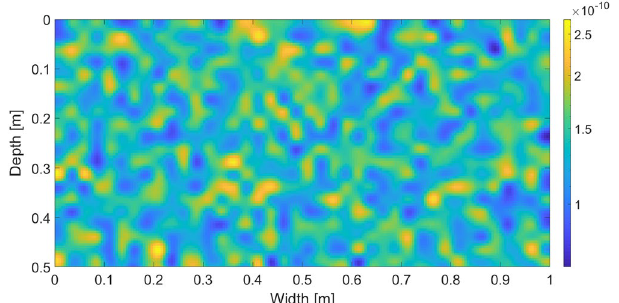
Figure 1. The distribution of the intrinsic permeability. Intrinsic permeability values are colour-coded according to the colour bar on the right.